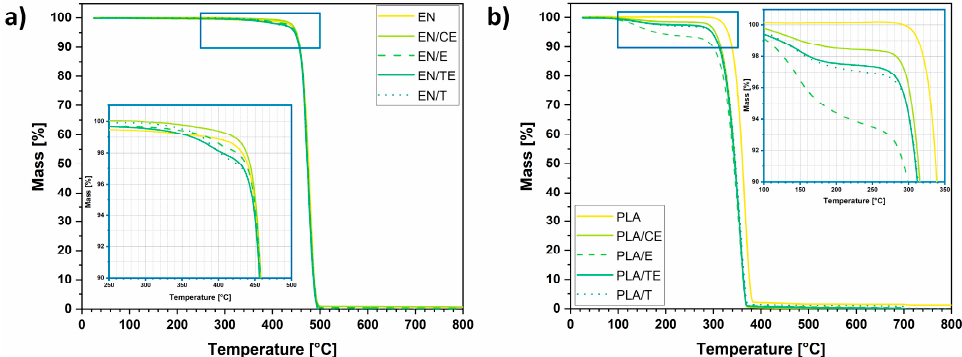
Figure 4. Thermogravimetric curves of ethylene–norbornene copolymer ( a ) and poly(lactic acid) ( b ) specimens.